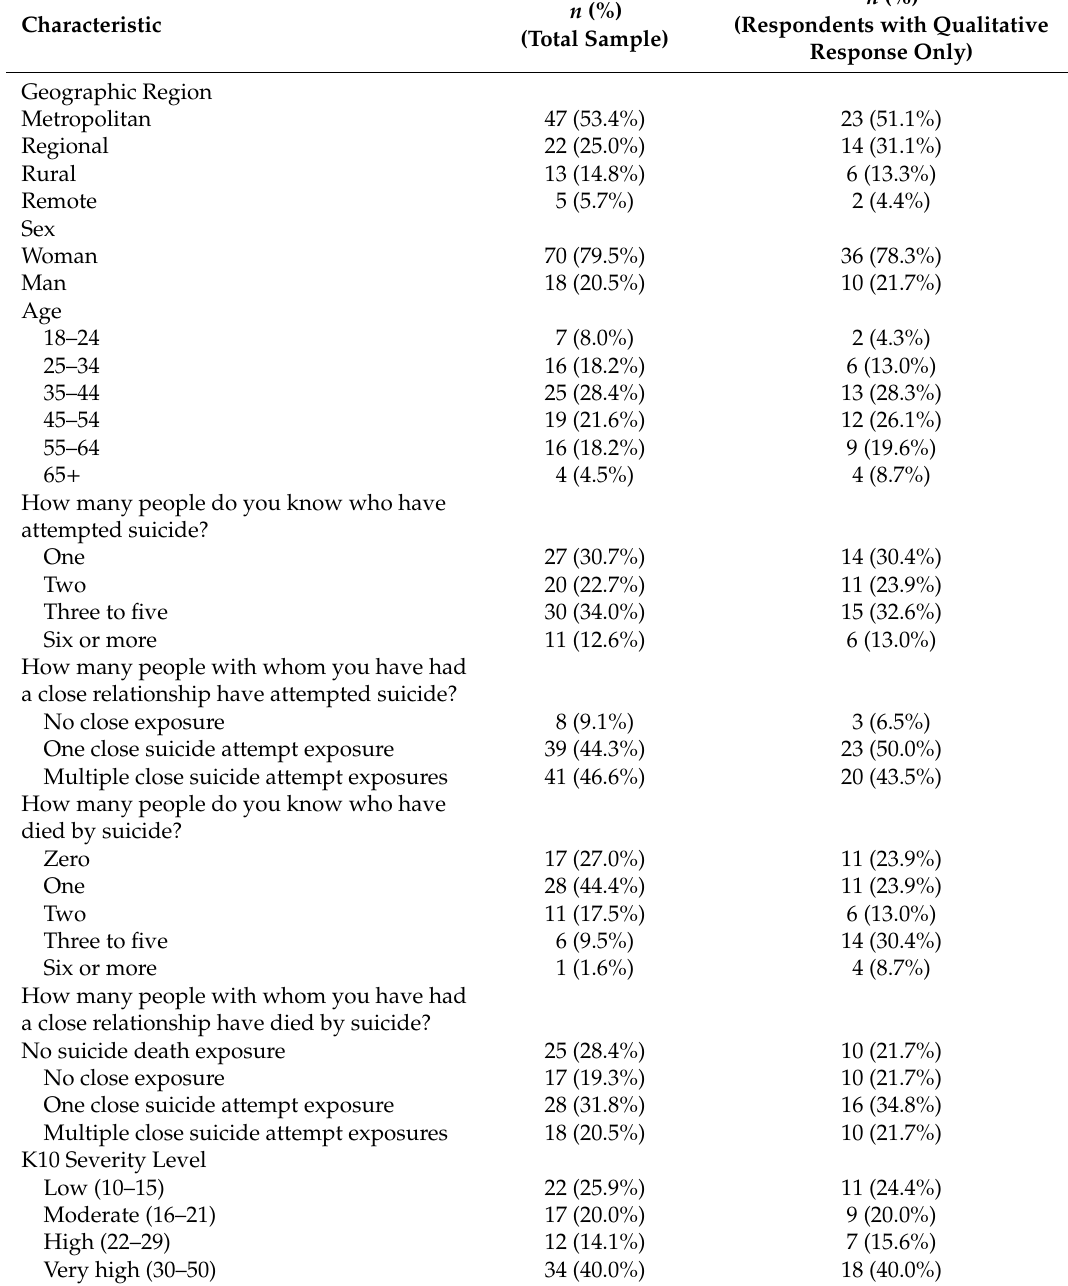
Table 1. Demographic and suicide exposure information for participants ( n =